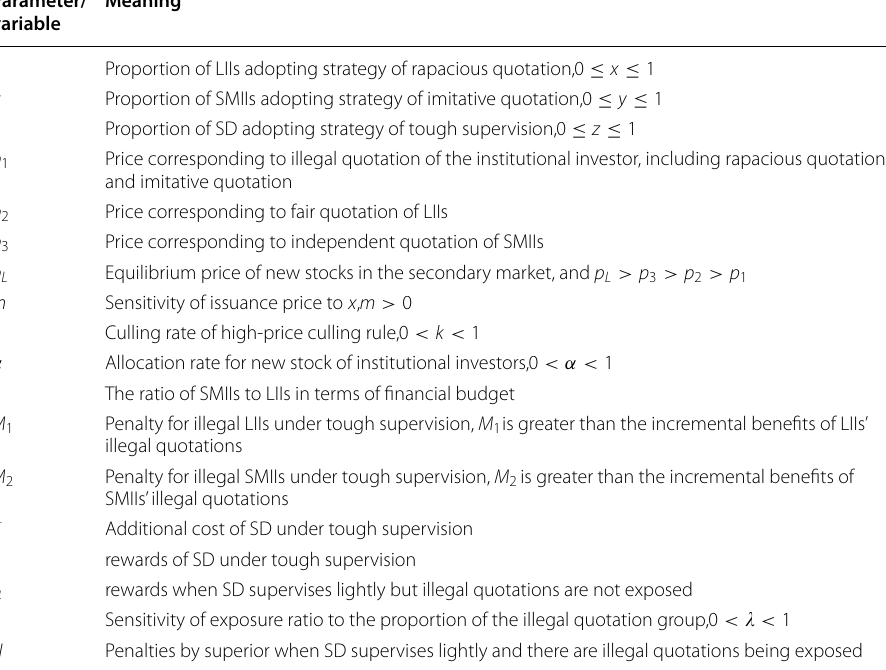
Table 1 Table of model parameters/variables Parameter/